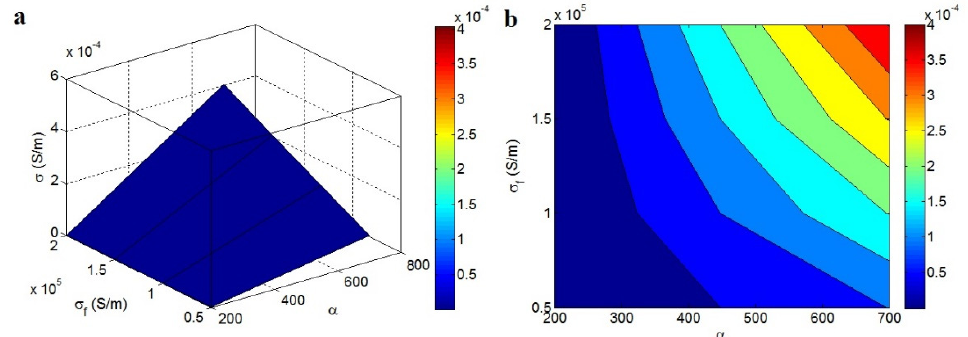
Figure 5. Predicted conductivity using α and σ f : ( a ) 3D and ( b ) contour pictures.